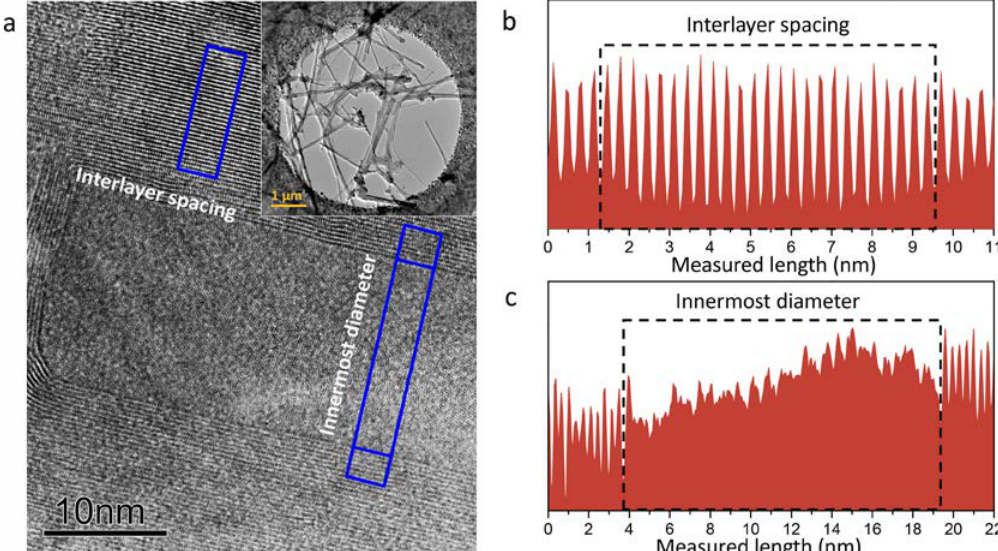
Figure 2. High-resolution lattice image of multi-walled boron nitride nanotubes BNNTs. ( a ) High-resolution lattice images of BNNTs, in which the interlayer spacing and the diameter of the innermost layer are indicated. The inset shows a low-magnification TEM image of the BNNT assembly; Line-scan profiles trace the interlayer spacing in ( b ), and the diameter of the innermost layer in ( c ).